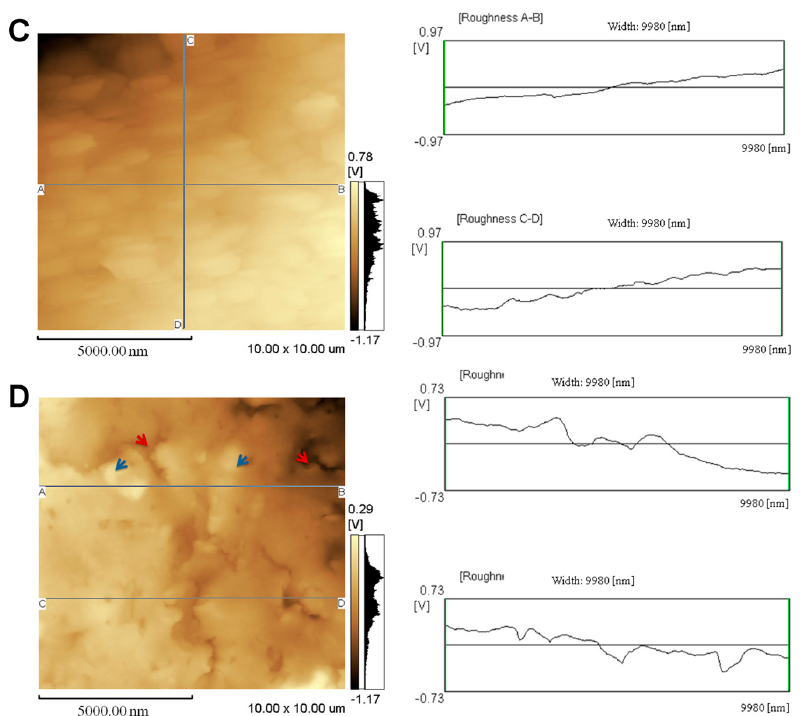
Figure 1. Representative two-dimensional atomic force microscopy (AFM) images and roughness profiles of the papaya leaf midribs ( A , B ) and latex ( C , D ) of healthy ( A , C ) and PMeV-infected papaya plants ( B , D ). Superficial differences between the samples from the healthy and infected plants. The infected samples exhibit valleys (red arrows) and peaks (blue arrows) that were not observed in the samples from the healthy plants.